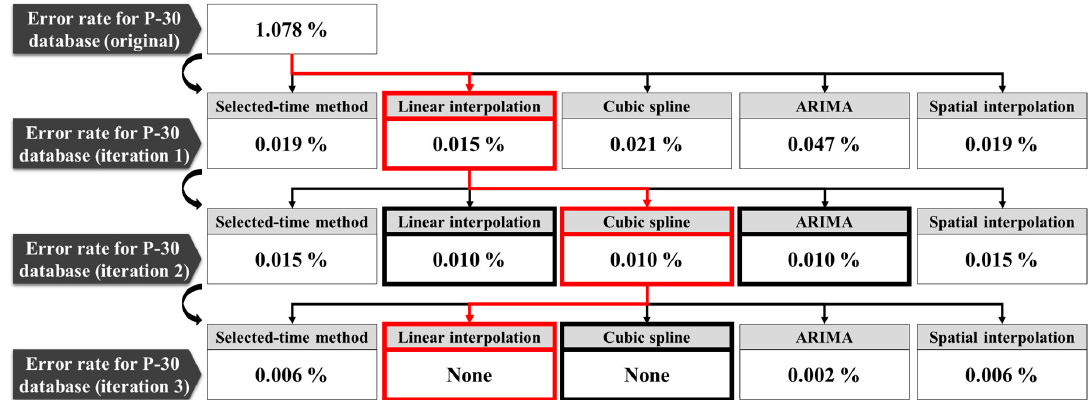
Figure 10. Improvement of data quality through the iterative quality control process for P-30 precipitation data.